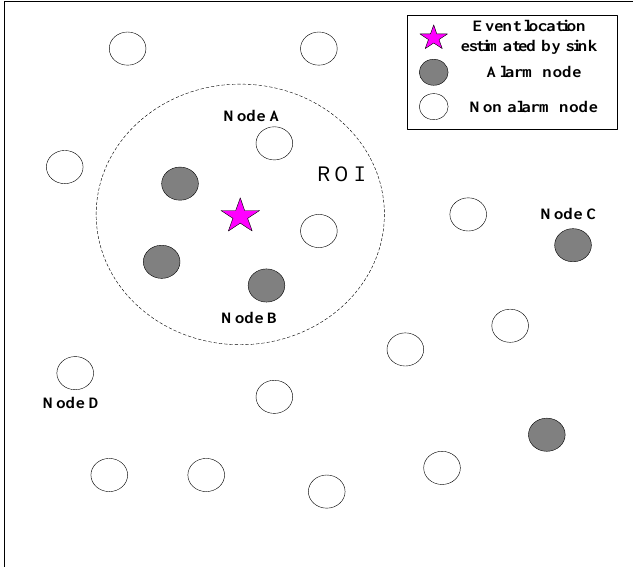
Figure 5. The state of nodes located in different